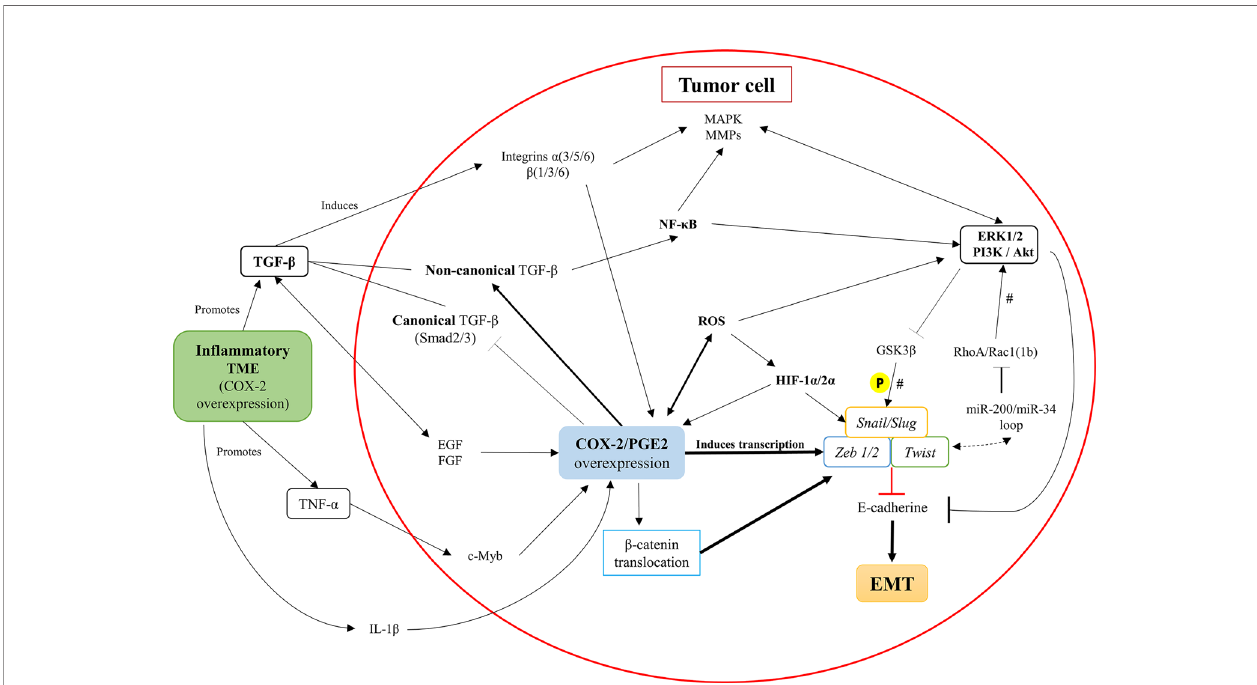
FIGURE 4 | Intracellular pathways in tumor cells that associate COX-2/PGE2 axis overexpression with the promotion of EMT. In fl ammatory components of the tumor microenvironment (TME), such as TNF-a and TGF-b, promote the up-regulation of the COX-2/PGE2 axis. Besides, the COX-2/PGE2 axis maintains its autocrine regulation through the activation of the PGE2 EP receptor. The COX-2/PGE2 axis overexpression activates the TGF- b non-canonical pathway (Smad- independent) at the expense of inhibiting the canonical-Smad dependent signaling, along with activation of integrins and secretion of MMPs. Further, the COX-2/ PGE2 axis overexpression increases the intracellular ROS levels and activates NF- k B oncogenic functions, which promotes pro-in fl ammatory signaling pathways and inhibits the GSK3 b factor. The inhibition of GSK3 b triggers the activation of master-EMT transcription factors (snail, slug, zeb1/2, and twist), which inhibit E- cadherin expression and fi nally facilitate the initiation and continuity of the EMT phenomenon. There is a potential EMT modulation associated with RhoA/ Rac1, according to the presence of microRNAs that would maintain a dynamic context-dependent role activating EMT transcription factors. #, their participation is established, but their presence does not determine the process; P,